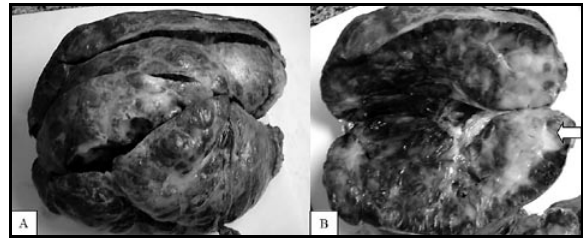
Figura 2 – Aspecto macroscópico da massa adrenal esquerda. A: grande massa encapsulada; B: superfície de corte mostrando área lipomatosa